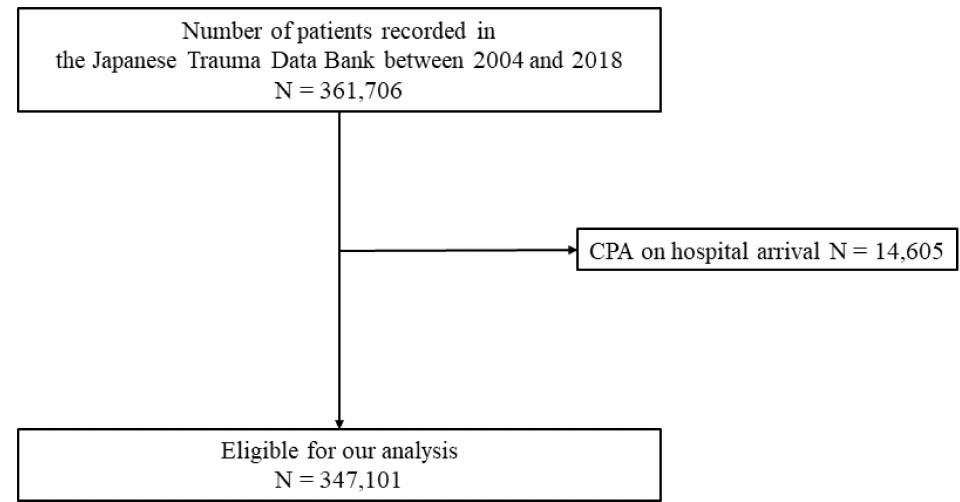
Figure 1. Patient flow. CPA, cardiopulmonary